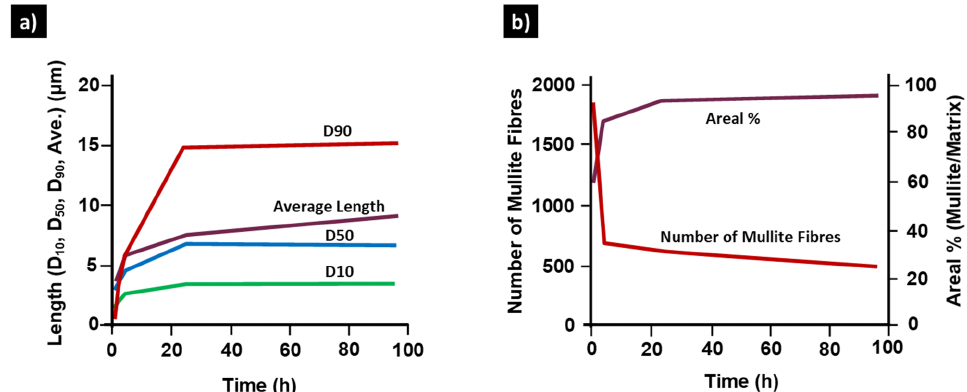
Figure 4. Fly ash 2: ( a ) changes to needle dimensions and their proportion with increasing sintering time at 1500 °C, ( b ) Changes to needle numbers and areal coverage with increasing sintering time at 1500 °C (Adapted from [30]).